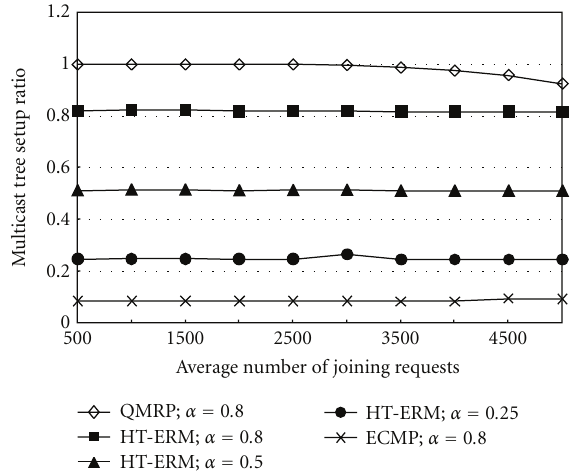
Figure 5: Multicast tree setup ratio versus group member joining